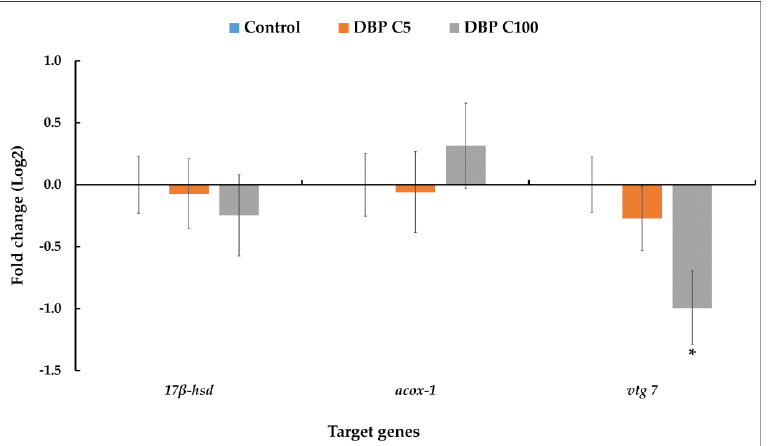
Figure 2. Disruption of the expression of three target genes ( acox1, 17β -hsd, vtg 7 ) revealed by qRT- PCR in zebrafish larvae exposed to solvent (DMSO control) and DBP (5 µg/L, C5 and 100 µg/L, C100) for 5 days. The CT values of each gene of interest were normalized to the expression of the housekeeping genes (rpl13a and EF1a) by using the 2 −ΔΔCt [29]. Results are given as mean ± standard deviation (n = 4) for each treatment group. A t -test was used to determine statistical differences between experimental groups and p < 0.01 was considered as significant. The asterisk shows a sta- tistically significant difference ( p < 0.01) between control and exposed